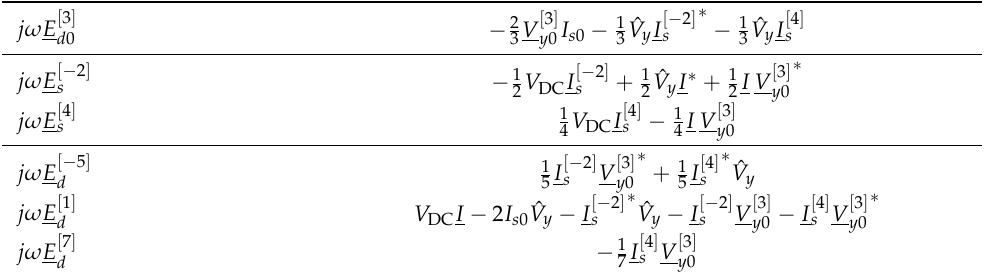
Table 3. Constants of the energies (29)–(32) for the circulating current (25) and the operating condi- tions